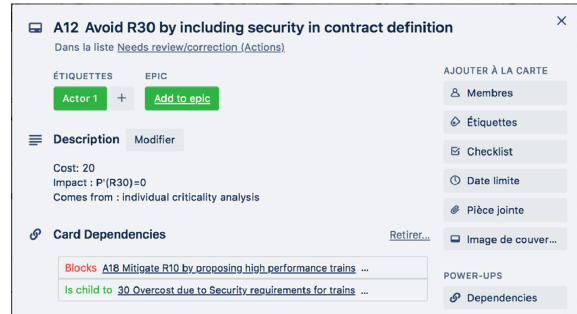
Figure 8: Status of a specific risk response action A